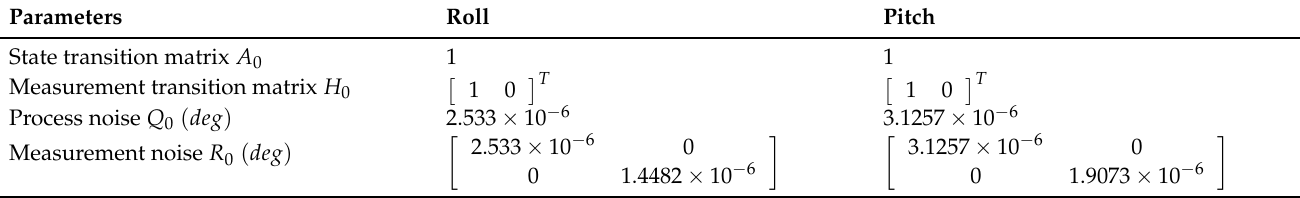
Figure 9. Experimental device. Table 4. Parameters of data fusion method based on gyro and accelerometer.